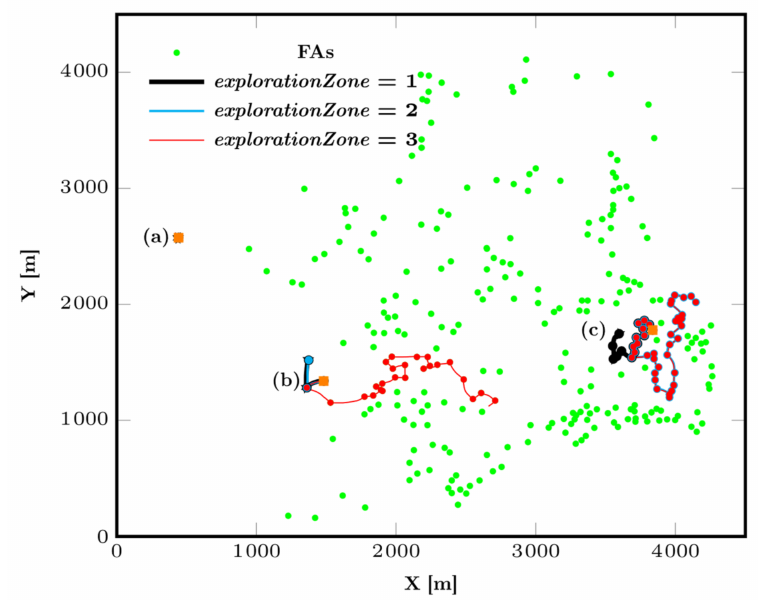
Figure 7. CM trajectories for abundanceReach = 50 and explorationZone values of 1, 2 and 3. The orange square indicates where the group of particles was generated. (a) The group remains completely stuck at the initial generation point. (b) The particles progress only for explorationZone = 3. (c) The density of the feeding area is much higher, and the particles can therefore go in many different directions as soon as the value of the exploration parameter is